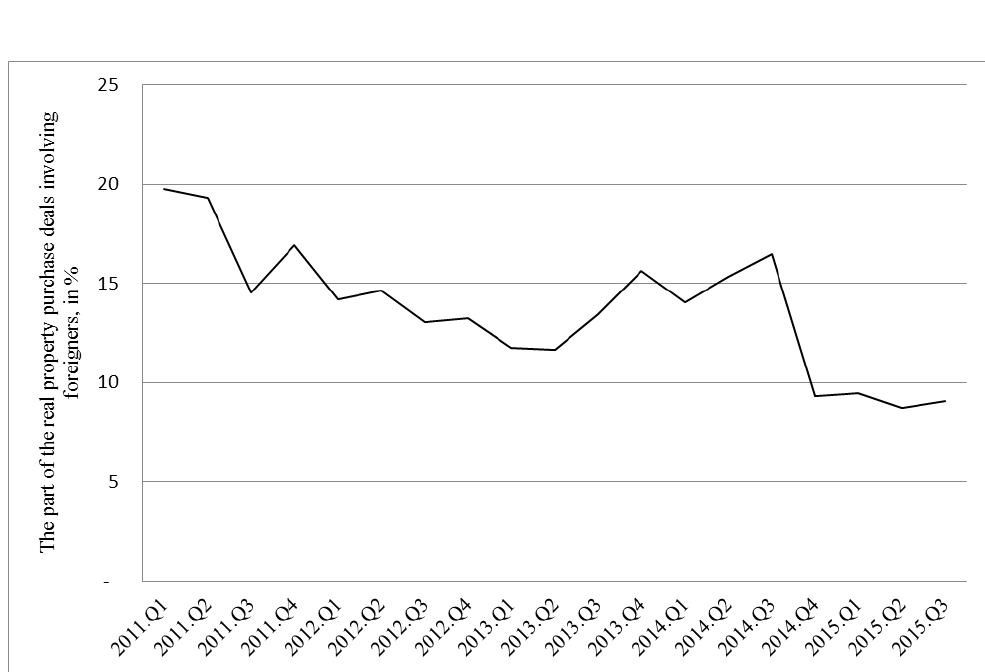
Fig. 1. Dynamics of the part of the total number of real property purchase deals in which foreigners were involved in Latvia from 2011 Q1 to 2015 Q3. Deals registered in the Land Registry of Latvia until 30.12.2015. (developed by the authors based on the data of the State Land Service of Latvia).